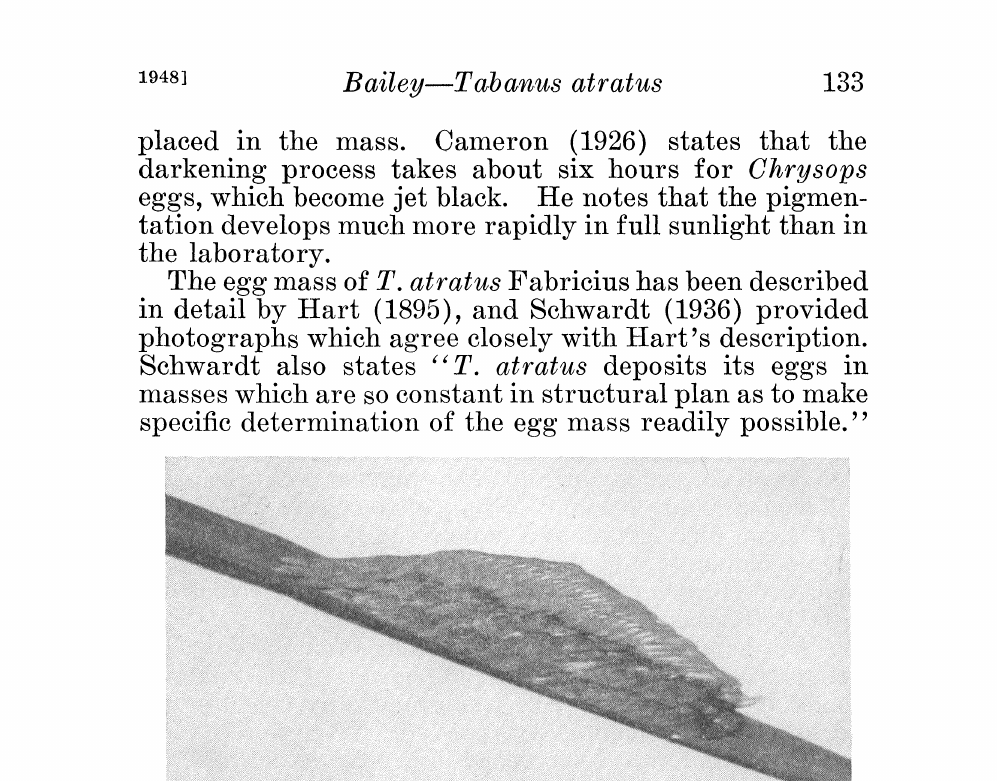
Fig. 1. Egg masses of Tabanus atratus nantuclensis. Photograph by Arthur F. Dewsnap Jr. (About 4 natural